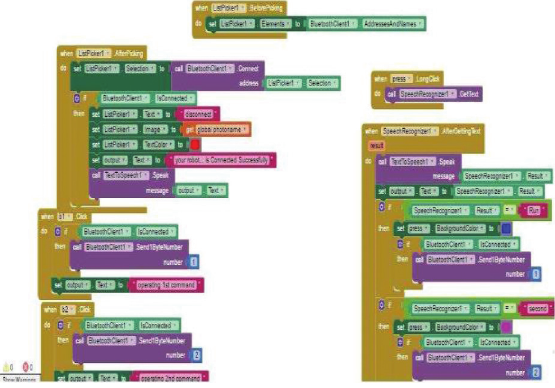
Figure 8: MIT APP Inventor programming block.